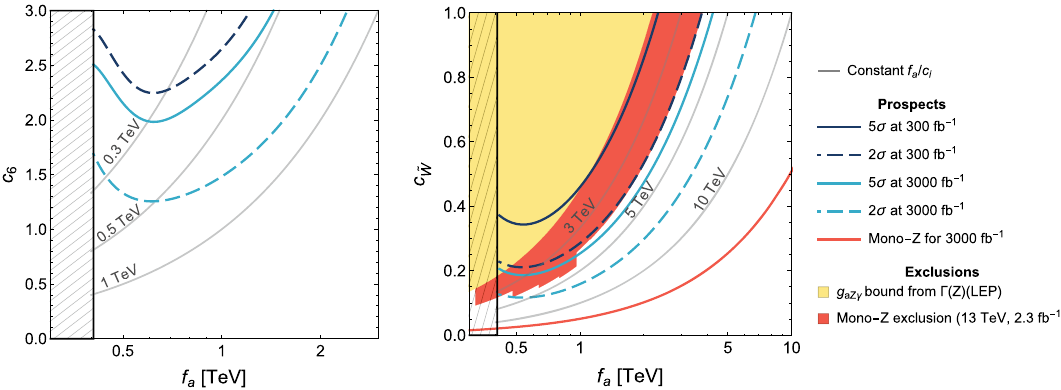
√ s = 13TeV LHC with 2 . 3fb − 1 would W